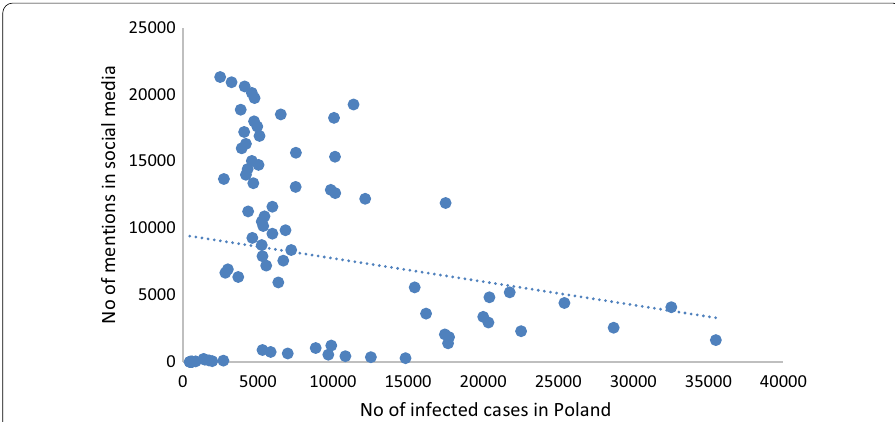
Fig. 2 Correlation between the number of economy-related mentions on social media sites and the number of infected cases reported in Poland